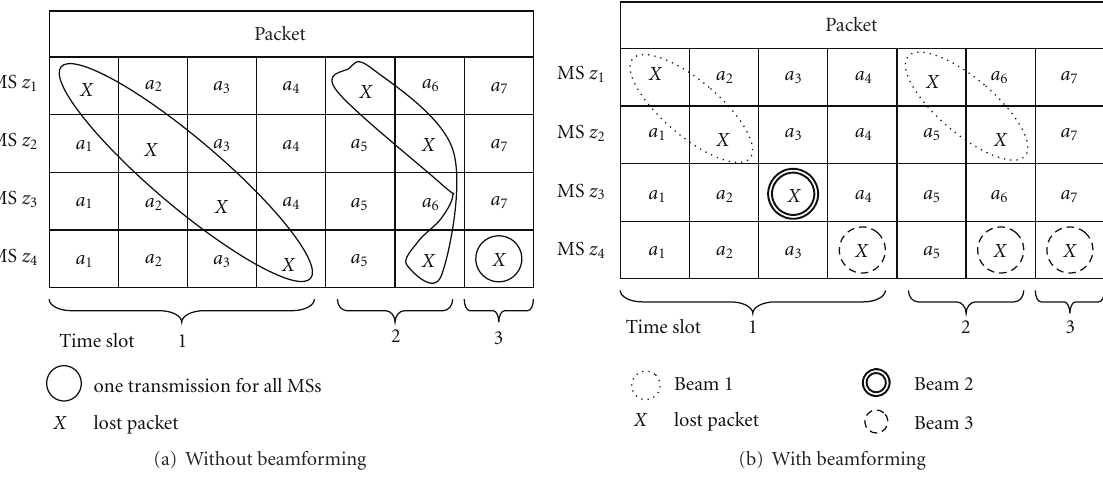
Figure 4: Retransmission techniques.